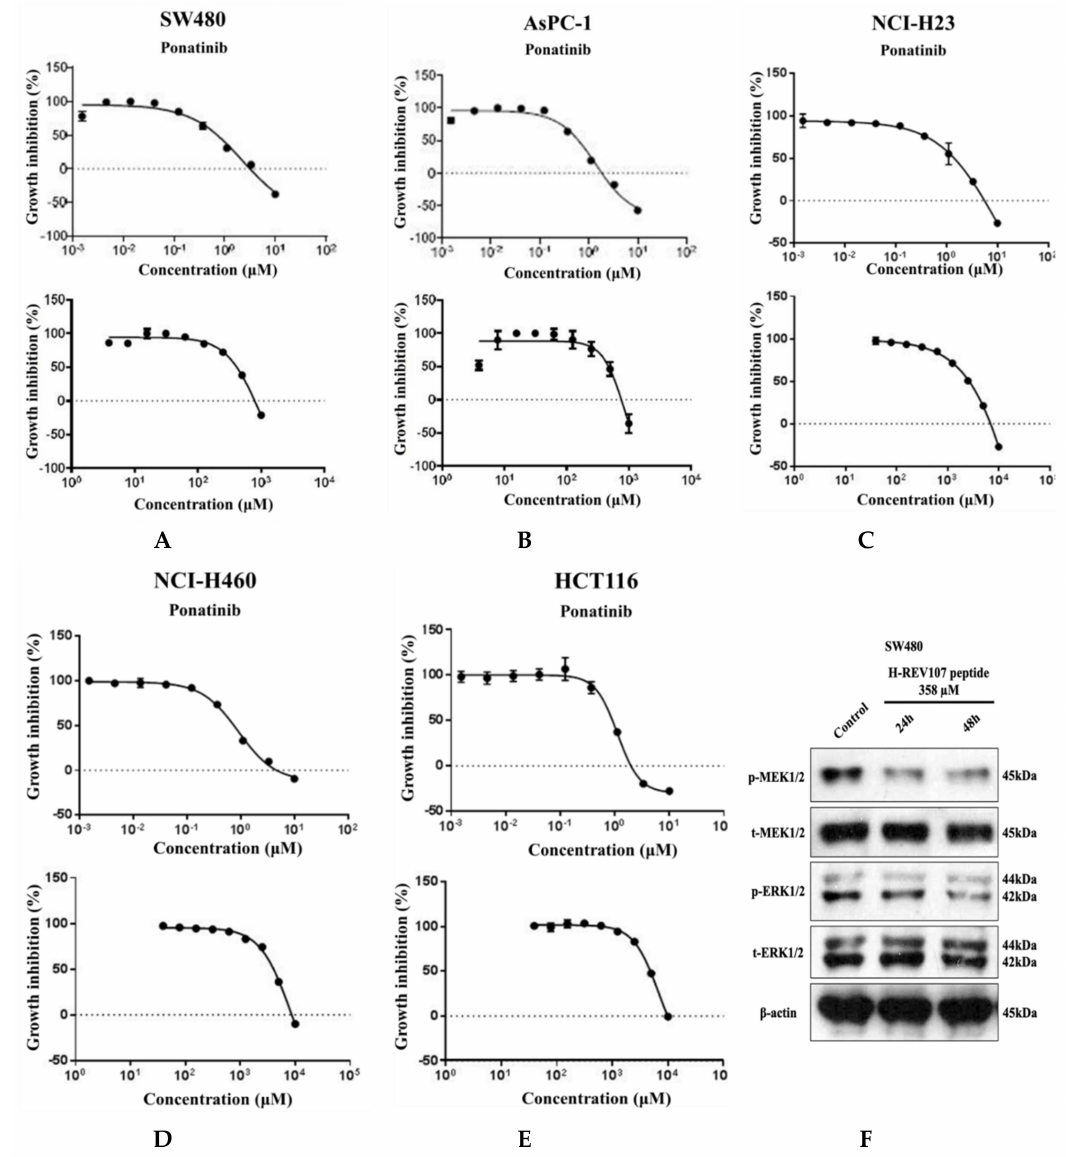
e ff ects of H-REV107 peptide on tumor cell proliferation, we examined H-REV107 peptide impact on the MEK / ERK signaling pathway in SW480 and AsPC-1 cells. We observed that H-REV107 peptide could decrease the phosphorylation levels of MEK / ERK in SW480 cell line, but the tendency to decrease of the phosphorylation levels of MEK / ERK in the AsPC-1 cell line was little. Western blotting had little e ff ect on the expression level of the total MEK / ERK protein (Figure